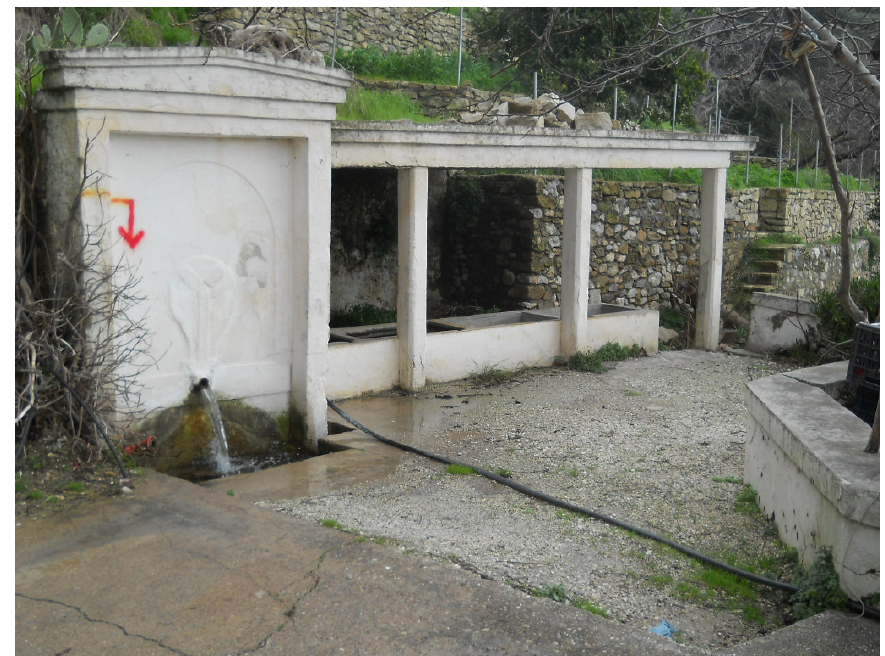
Figure 10 . Fountain of the early 1960s in which the water from aqueduct 2 ends up to